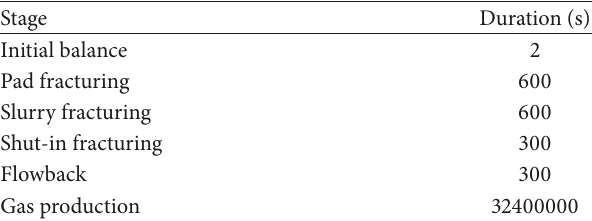
Table 1: Duration of fracturing and gas production stages. Table 2: Basic physical parameters.